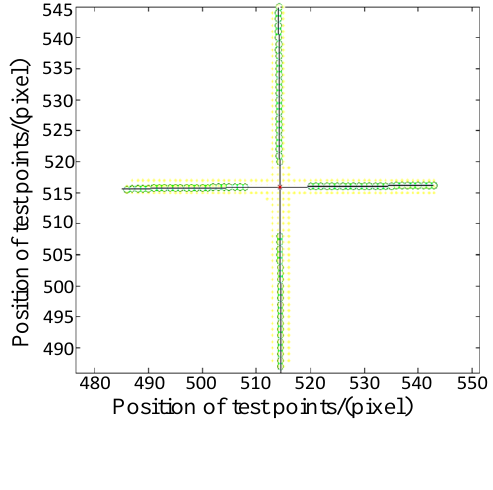
Figure 15. Sketch map of the solution of the gravity center of the